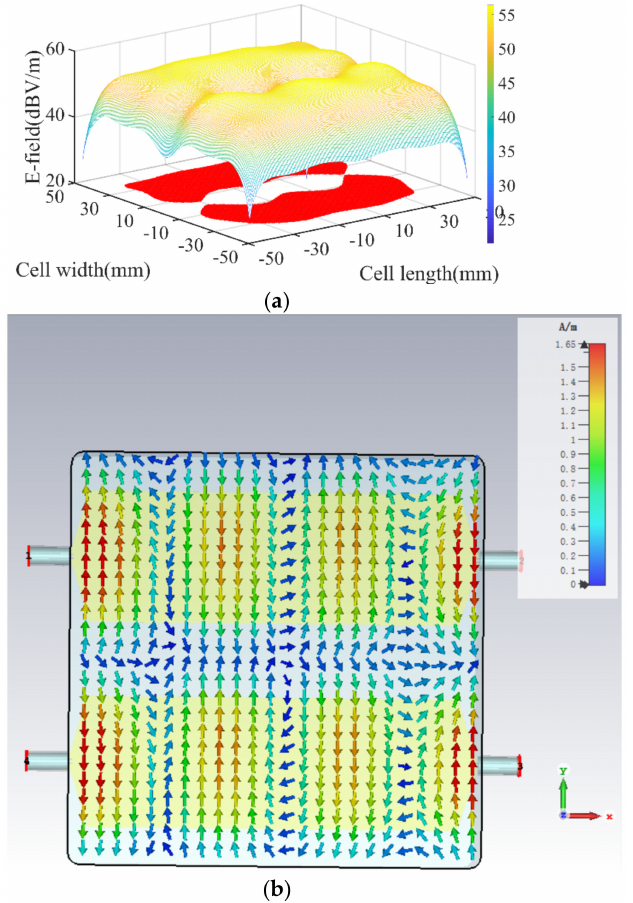
Figure 13. Field distribution at the top area of the IC-Stripline cell based on image theory. ( a ) The electric field distribution (the red shaded area is the horizontal projection of the 3 dB uniform field region). ( b ) The magnetic field